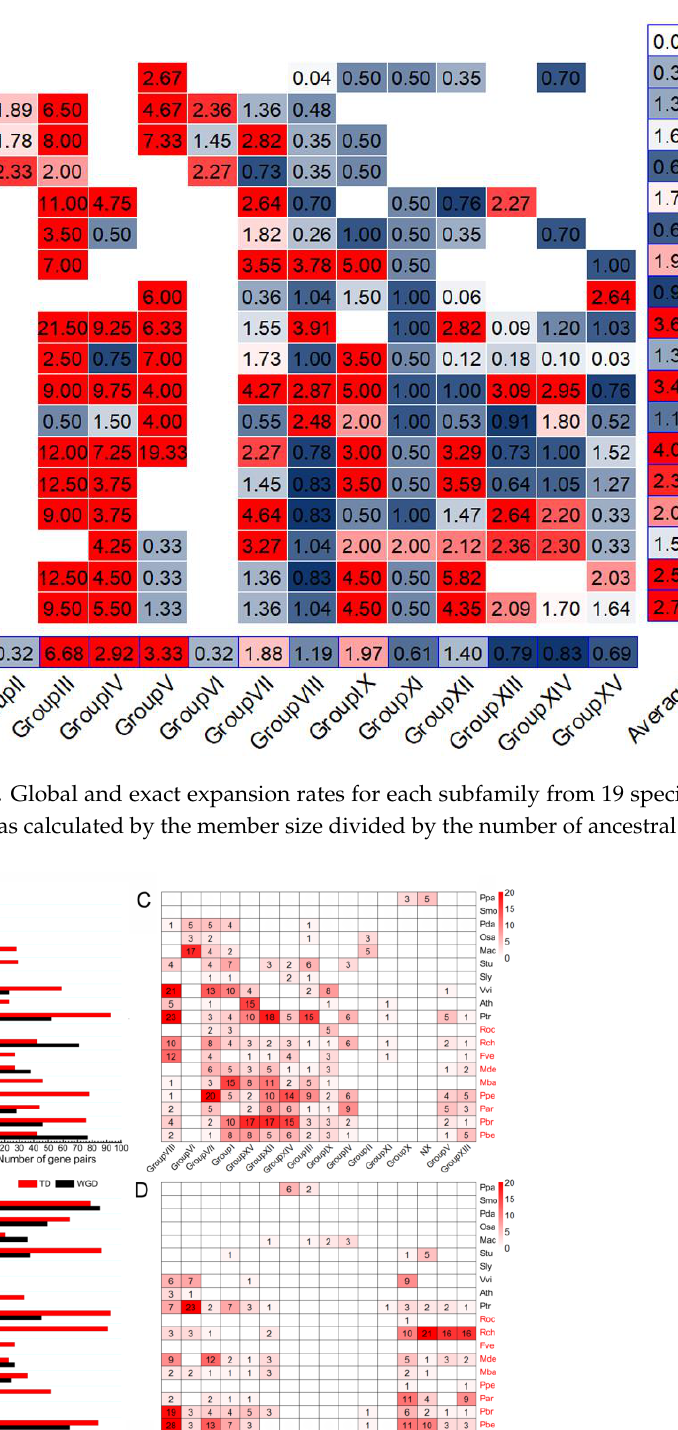
Figure 4. The total and exact duplication events of NLR family in 19 species. ( A ) and ( B ) Duplicated gene pairs in each species ( A ) and group ( B ), respectively. ( C , D ) Exact WGD ( C ) and TD ( D ) events in each NLR group from all 19